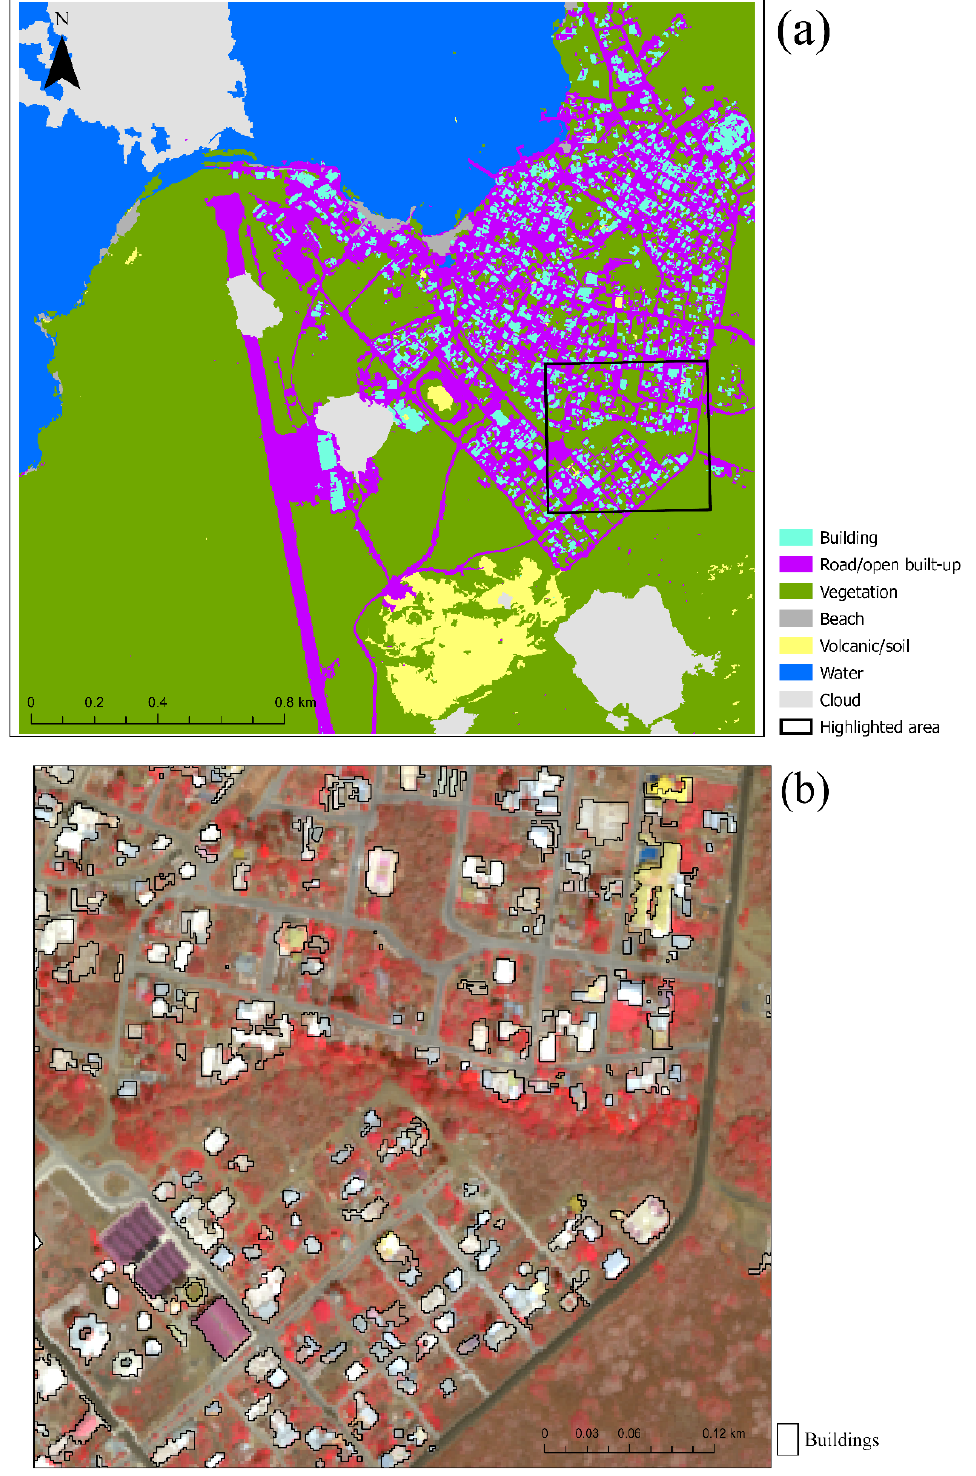
Figure 4. OBIA classification results using four spectral bands of a WorldView-2 image as input: ( a ) Overview of all land cover classes; locations with obvious cloud/shadow were manually masked out. ( b ) Buildings (polygons) for the highlighted area.